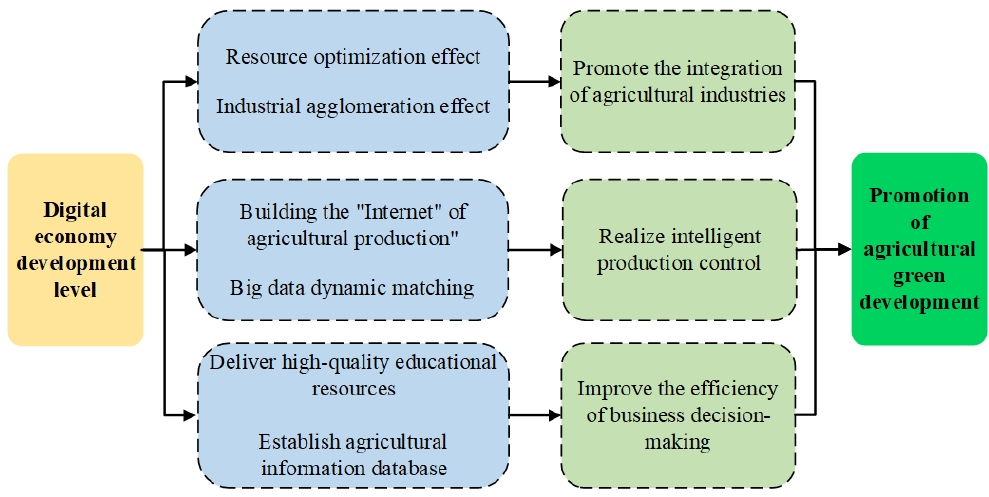
Figure 1. Mechanism path diagram.